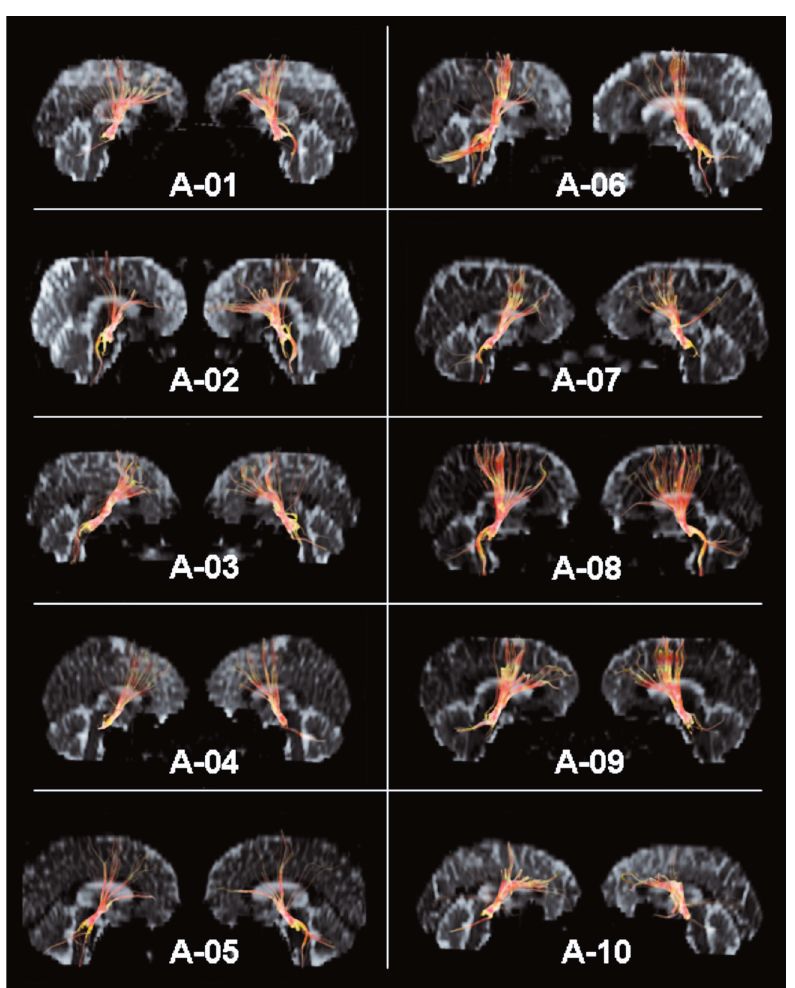
Figure 3. Arnold’s bundle tractograms (right and left) of the 10 subjects (A-01 to